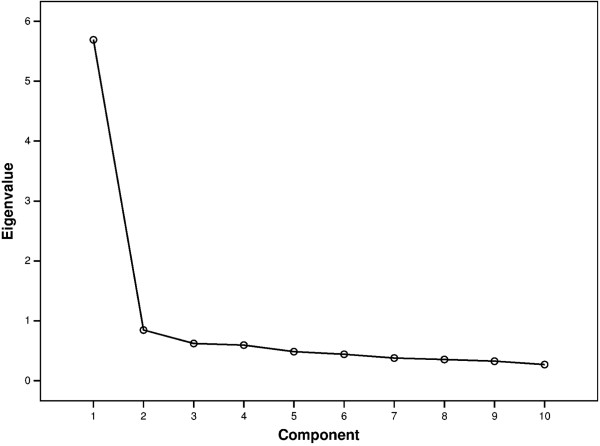
Factor analysis of the BSFC-s score: scree plot. Factor loadings on component 1: item 1: .81; item 2: .81; item 3: .76; item 4: .76; item 5: .81; item 6: .80; item 7: .78; item 8: .76; item 9: .62; item 10: .63.